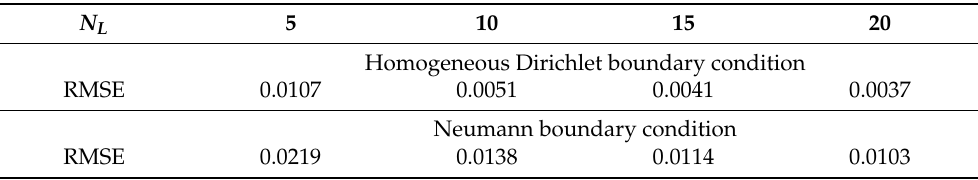
Table 5. RMSE for simulations with different vertical layers and different boundary conditions.